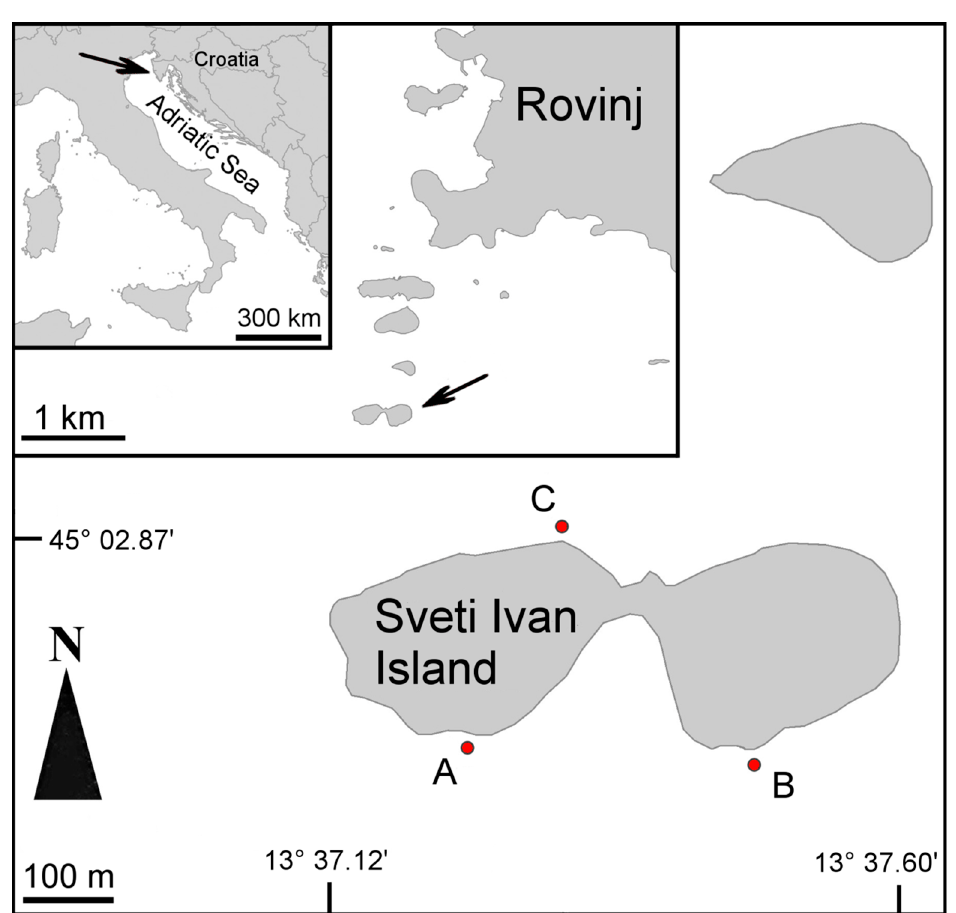
Figure 1. Location of the study area and sampling stations ( A – C ). Arrows indicating city of Rovinj area and Sveti Ivan Island.